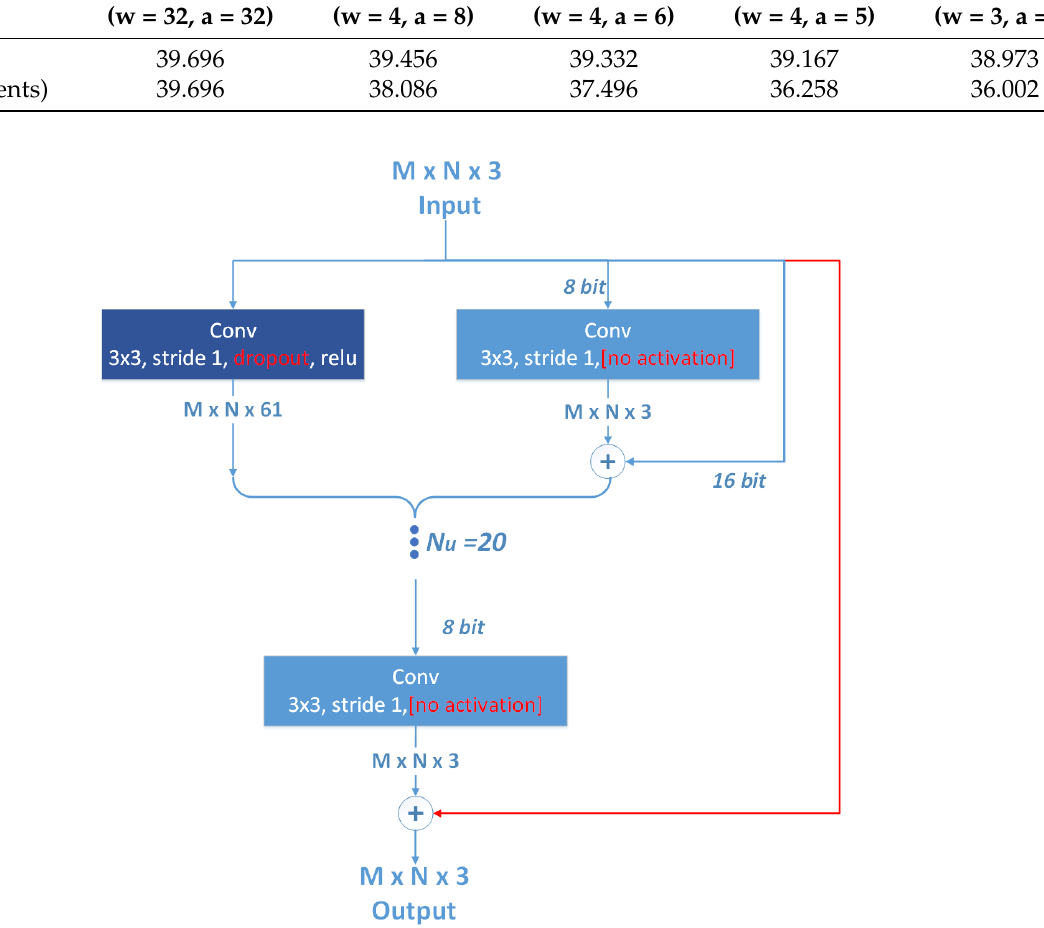
Table 3. PSNR [dB] results on joint denoising and demosaicing for different bitwidths. Bits Bits